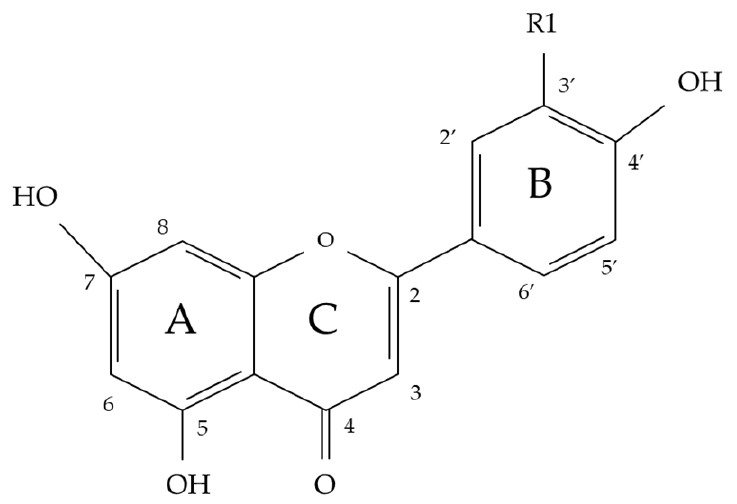
Figure 1. General graphic representation of flavones.